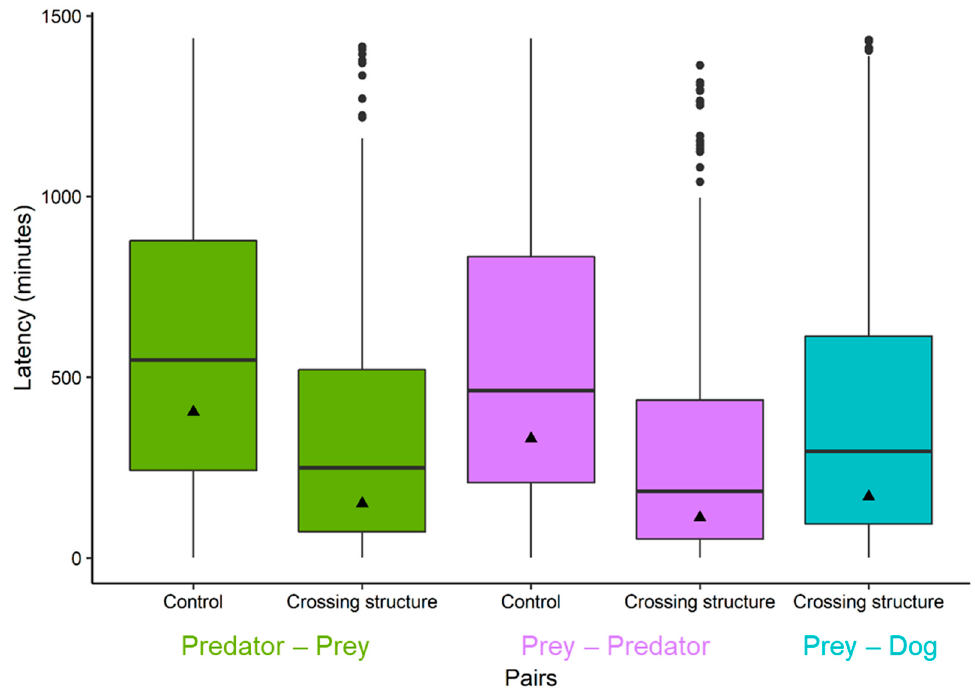
Figure 2. Comparison of geometric mean latencies (black triangle) and median latencies between predator–prey, prey–predator, and prey–dog pairs at crossing structures and control site. Error bars indicate 95% confidence intervals. Black dots represent outliers. Table 1. Geometric mean latencies (minutes) between predator–prey, prey–dog and prey–predator under crossing structures on NH 44, Pench Tiger Reserve, Maharashtra, India.